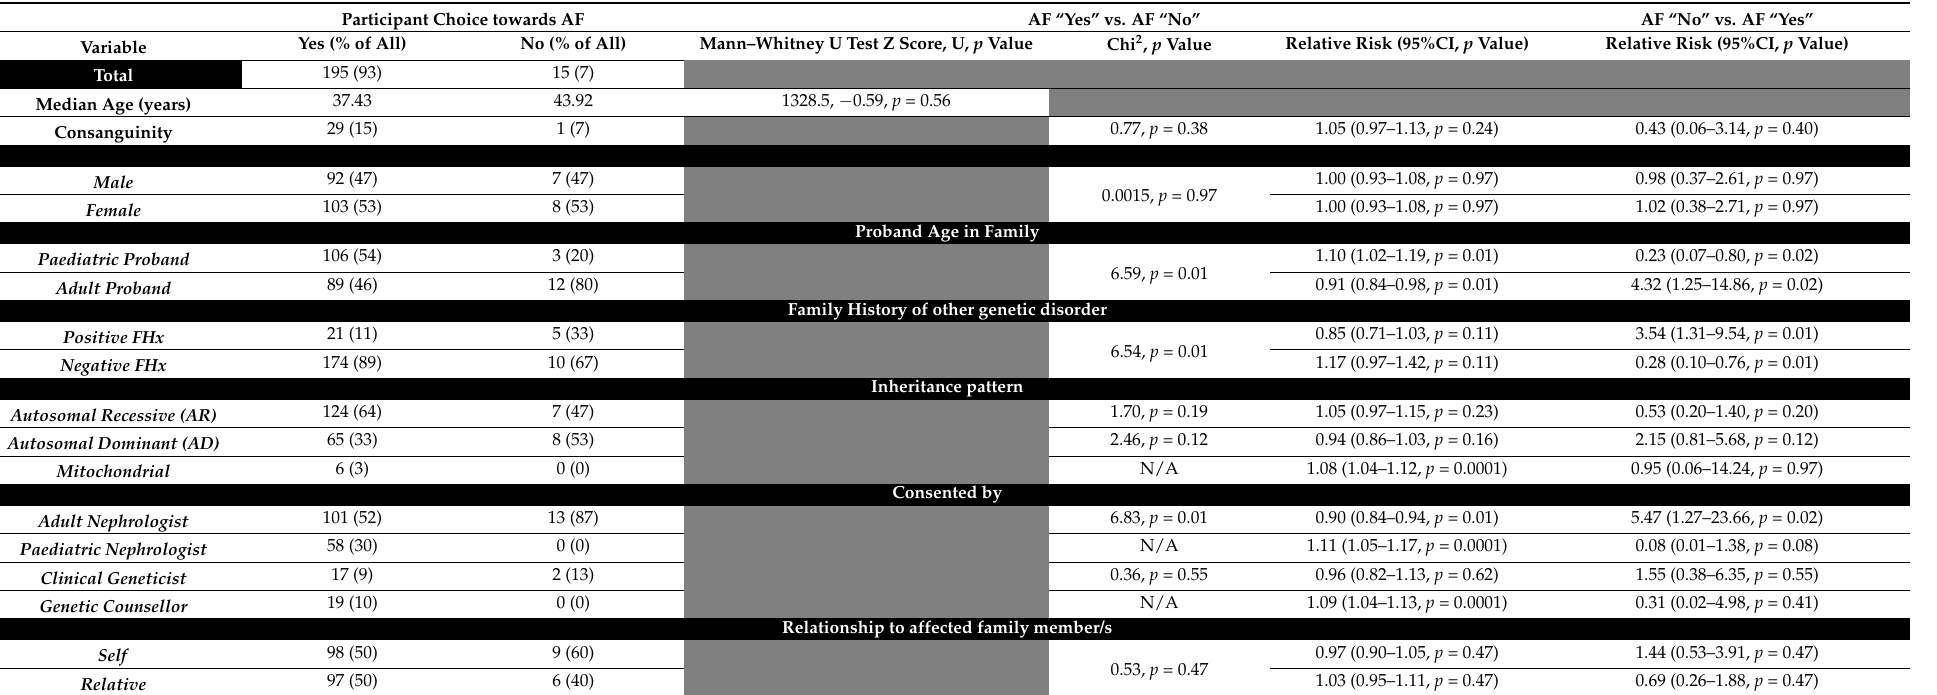
Table 1. Characteristics of the Additional Findings (AF) choice